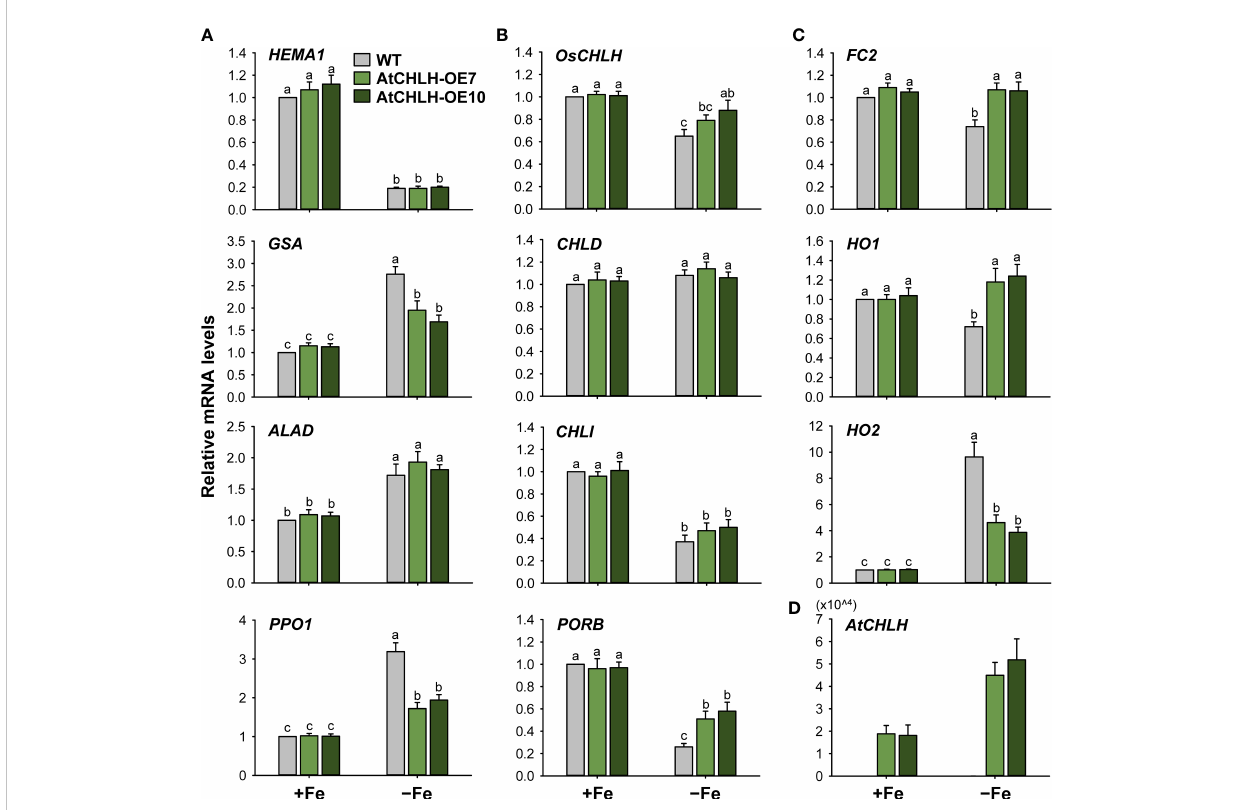
FIGURE 4 Fe de fi ciency-induced changes in the expression of genes encoding enzymes from the porphyrin biosynthetic pathway in leaves of WT and transgenic plants. (A) Common branch. (B) Mg-porphyrin branch. (C) Fe-porphyrin branch. (D) AtCHLH transgene in Mg-porphyrin branch. The plants were subjected to the same treatments as in Figure 3. Treatment notations are the same as in Figure 3. Total RNAs were extracted and reverse transcribed. The resulting fi rst-strand cDNAs were used as templates for qPCR, using Actin as an internal control. All relative expression levels were normalized to the +Fe WT control values, which were set to 1. Values are means ± SE, and data from three independent experiments are